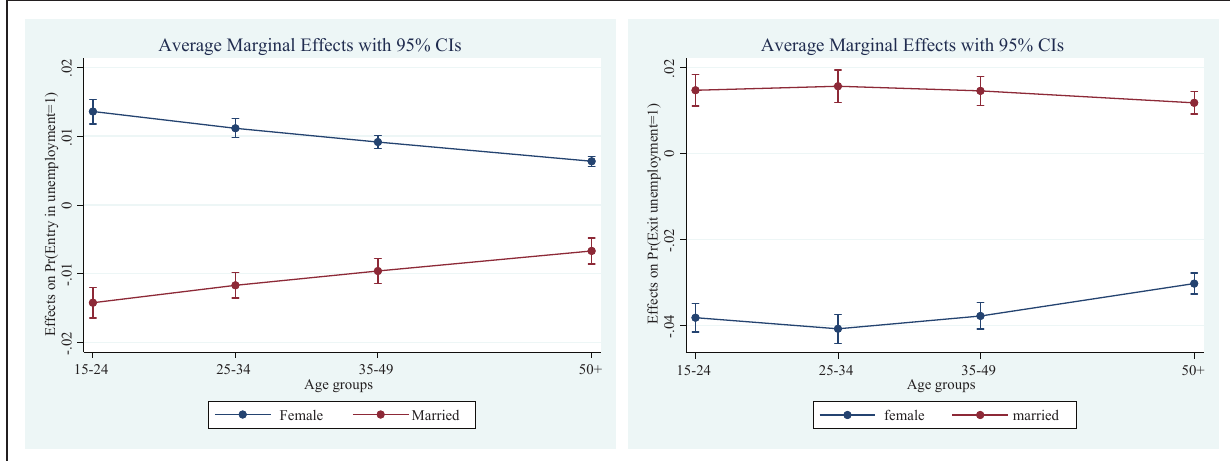
Average marginal effects of entering and exiting unemployment based on gender and marital status by age (total